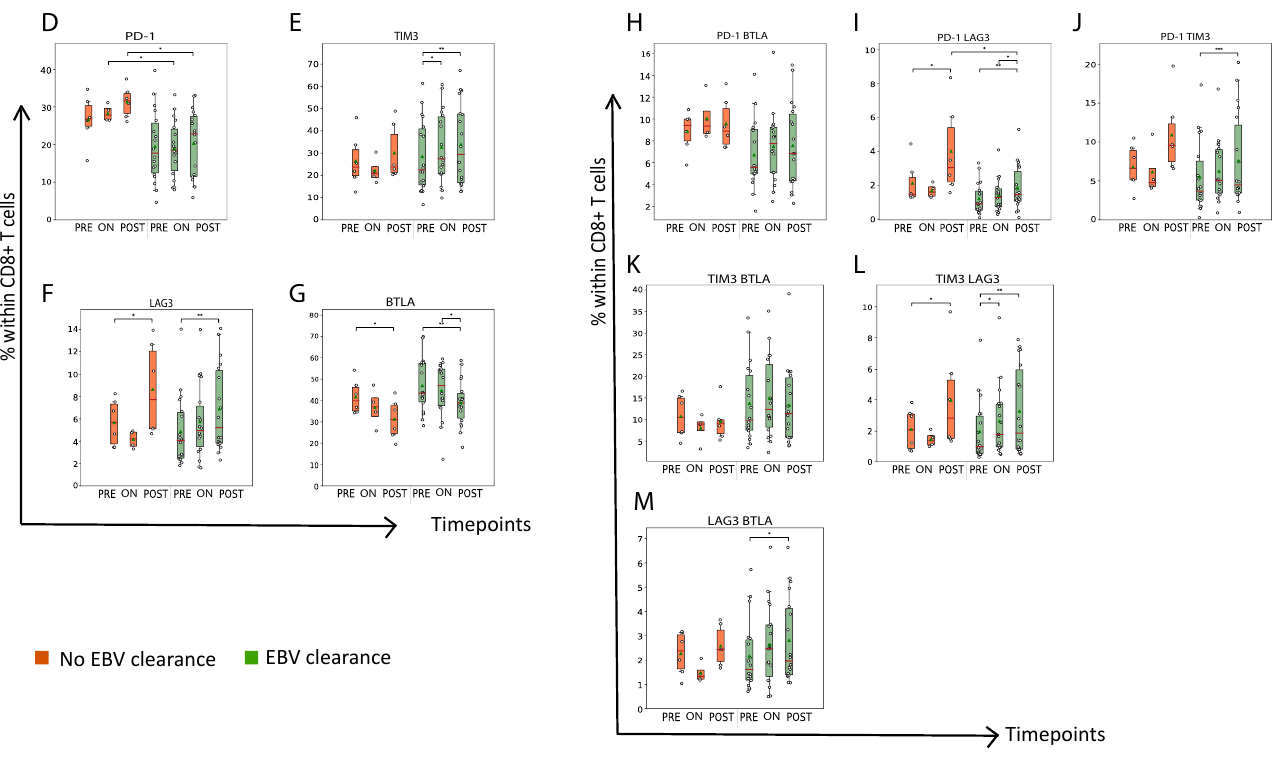
Figure 2. Plasma EBV DNA clearers harbor lower frequency of PD1-expressing CD8+ T cells on- and